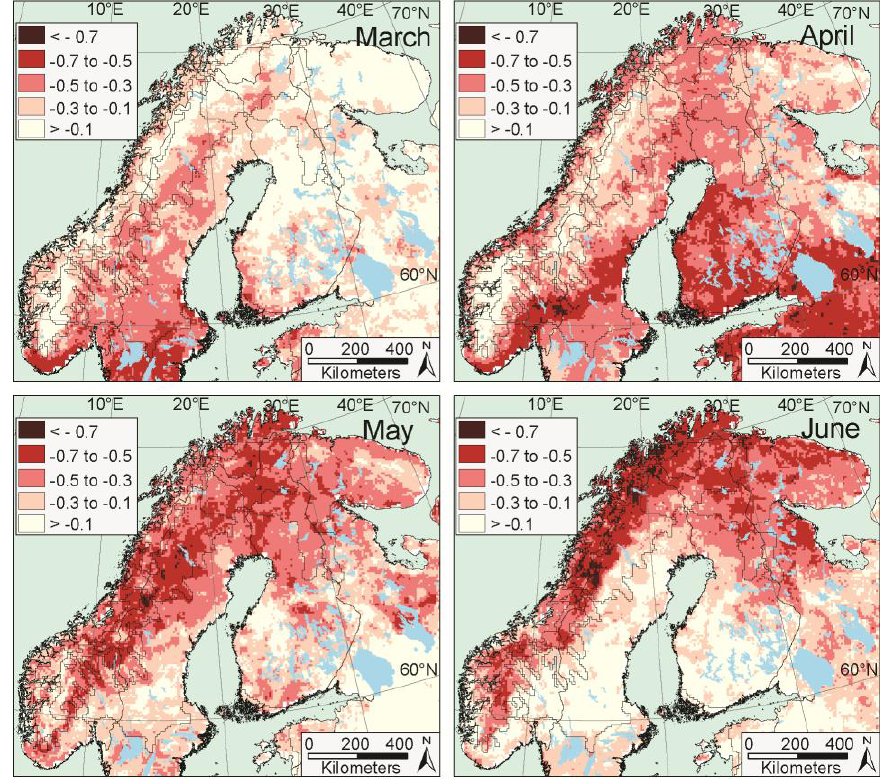
Figure 5. Correlation between the start of the growing season and temperature in ( a ) March, ( b ) April, ( c ) May and ( d ) June. Red is large (negative) correlation between temperature and the start of the growing season.